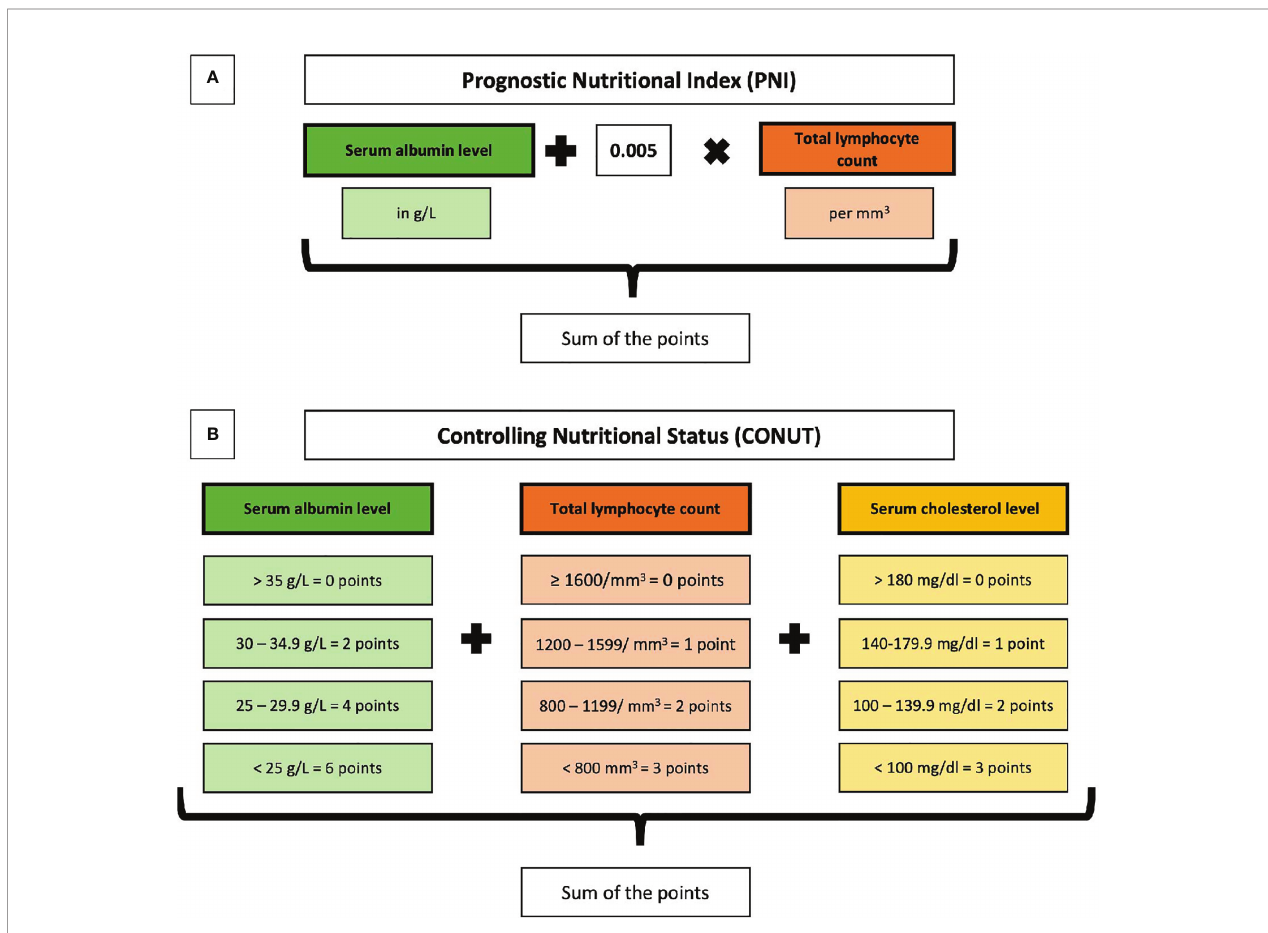
FIGURE 2 | Overview of the calculation and parameters included in the Prognostic Nutritional Index (PNI) (A) and the Controlling Nutritional Status (CONUT) (B)